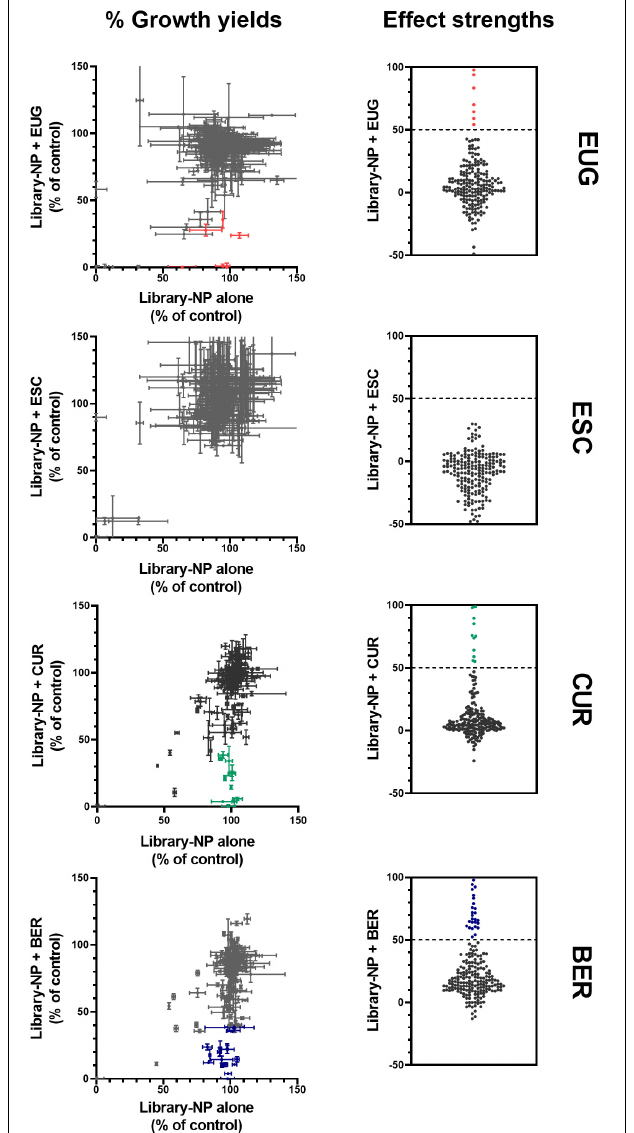
FIGURE 3 | A screen of library NPs in combinations with selected NPs of interest, against the growth of S. cerevisiae. Left: normalized growth of S. cerevisiae W303 was calculated from OD 600 values after 24 h with and without NPs, for each of the library NPs both in the absence ( x -axis) or in the presence ( y- axis) of 750 µ M eugenol (EUG), 12.5 µ M β -escin (ESC), 50 µ M curcumin (CUR), or 350 µ M berberine (BER). Each point represents the mean ± SEM calculated from two independent experiments. Right: effect strengths were determined from [(% growth with library agent) - (% growth with library agent + second agent)] for the different combinations; color is used to highlight those with an effect strength > 50. The underlying data for each combination from the screen are listed in Supplementary Table 1